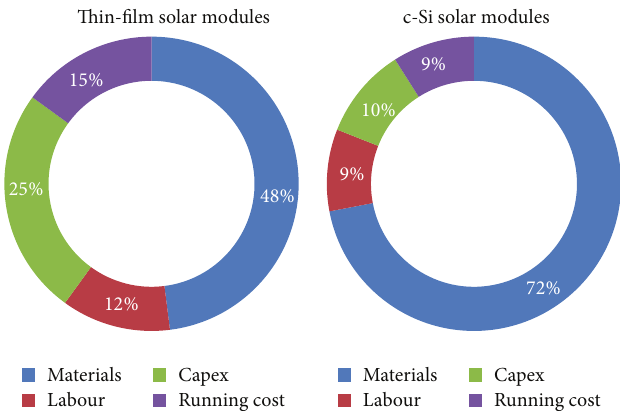
Figure 7: Cost reduction—material consumption for different photovoltaic panel technologies [17].